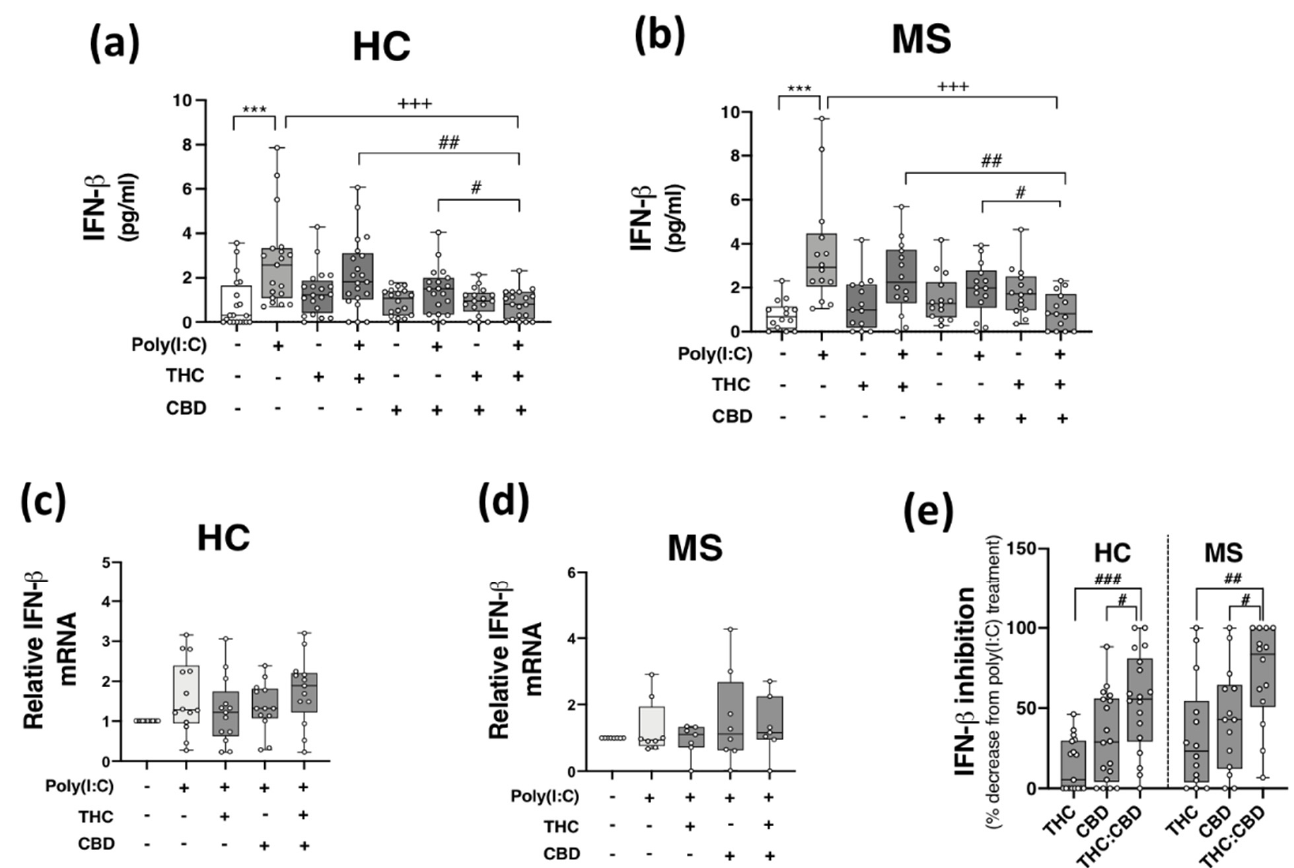
Figure 3. THC:CBD inhibits TLR3-induced IFN- β protein expression in PBMCs from HC subjects and pwMS. Treatment of PBMCs from ( a ) HCs and ( b ) pwMS with poly(I:C) (10 μ g/mL; 24 h) in- creased IFN- β protein expression. Pre-treatment with THC (10 μ M) and CBD (10 μ M) in combina- tion (1:1) (45 min pre-treatment) significantly inhibited poly(I:C)-induced IFN- β protein expres- sion in PBMCs from ( a ) HCs (Kruskal–Wallis statistic = 30.4) and ( b ) pwMS (Kruskal–Wallis statis-